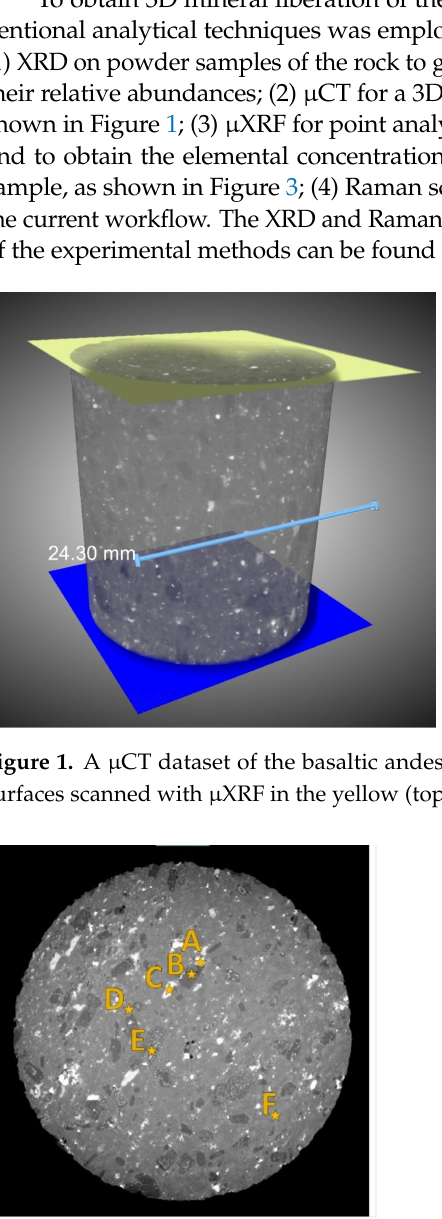
Figure 2. Positions of point analysis (A–F) for µ XRF and Raman measurements on the bottom surface of the core plug sample. These data were used in extension to the K-means clustering of the µ XRF maps and XRD mineral analysis to elucidate mineral segmentation of the